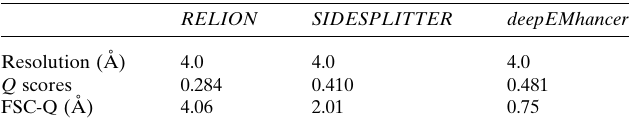
Table 2 Validation metrics for different reconstructions of 20S proteasome. FSC resolution first, followed by two map-to-model validation criteria.